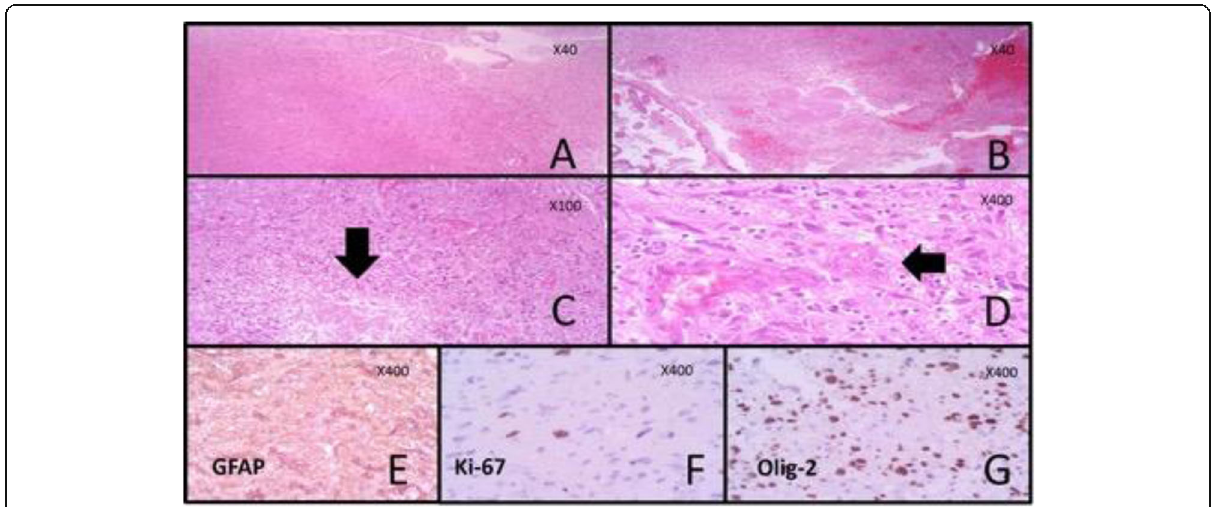
Fig. 4 Sections show an ill-defined relatively hyper cellular mass with neurofibrillary background ( a , b × 40, hematoxillin and eosin) with areas of necrosis ( c , arrow, × 40, hematoxillin and eosin) and microvascular proliferation ( d , arrow, × 40, hematoxillin and eosin). Immunohistochemical evaluation shows diffuse positivity for GFAP ( e , × 400) with low (about 5%) Ki-67 positivity ( f , × 400) and high expression of Olig-2 ( g , × 400)